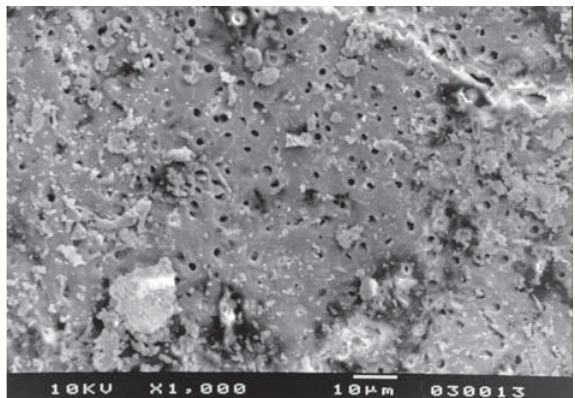
Figure 2- Scanning electron microscopy (SEM) micrograph of root dentin surface showing partial closure of the dentin tubules entrances by smear layer, corresponding to score (cid:30)(cid:11)=H(cid:10)(cid:10)(cid:12)?(cid:11)=G(cid:29)(cid:28)(cid:31)(cid:31)(cid:31)(cid:11)(cid:8)(cid:5)(cid:20)(cid:9)(cid:16)#(cid:17)(cid:5)(cid:7)(cid:16)(cid:10)(cid:9)?